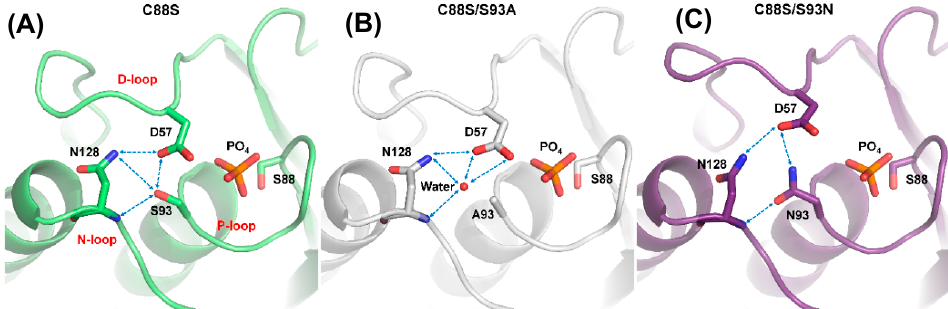
Figure 4. Disruption of DPN–triloop interaction in the crystal structures of S93 mutants. ( A – C ) The crystal structures of C88S (green), C88S / S93A (white), and C88S / S93N (purple) indicated how the mutation affected the hydrogen bonding network. The hydrogen bonds are shown by blue dotted lines, and a water molecule is shown as a red ball. ( A ) The crystal structure of C88S was prepared to compare with the S93 mutants, and the DPN–triloop interaction was unchanged. ( B ) S93 was replaced with alanine, and the structure was similar to that of C88S. A water molecule (W61) participated in forming the hydrogen bonding with the side chain of D57, the side chain of N128, and the backbone amide of N128. ( C ) S93 was replaced with a somatic mutant, asparagine. N93 formed the hydrogen bonding with the side chain of D57 and the backbone amide of N128.